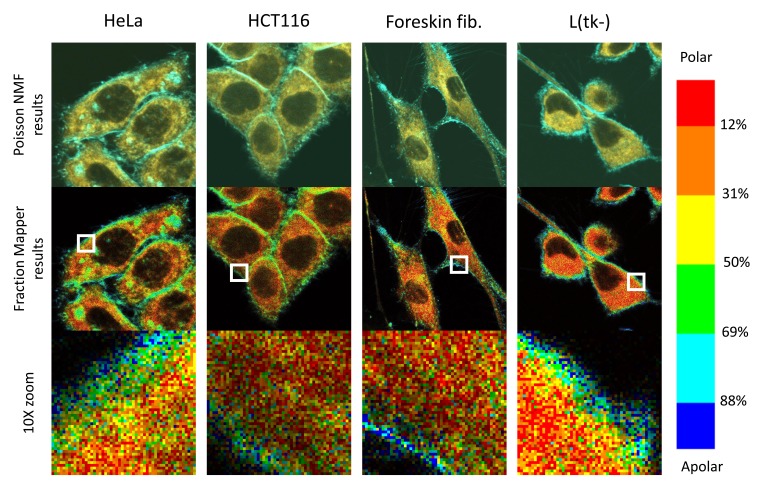
C-laurdan stains various cell types in similar patterns.Human HeLa cells (first column), HCT116 cells (second column), foreskin fibroblasts in primary culture (third column) and mouse L(tk-) cells (fourth column) were all grown on glass coverslips before staining with C-laurdan, imaging and analysing the images by the standard procedure, as described in Methods. Top row: overlay of the two channels obtained after spectral decomposition with PoissonNMF (cyan, apolar environment; orange, polar, water-exposed environment). Middle row: the two channel stacks were processed with the Fraction Mapper plugin using the six-colour 2,3,3,3,3,2 LUT shown on the right-hand side. Bottom row: 10x magnifications of the 52×52 pixel regions indicated by white squares in the middle row. Each pixel is 100×100 nm, and each picture, taken at zoom 4, covers 52×52 microns.